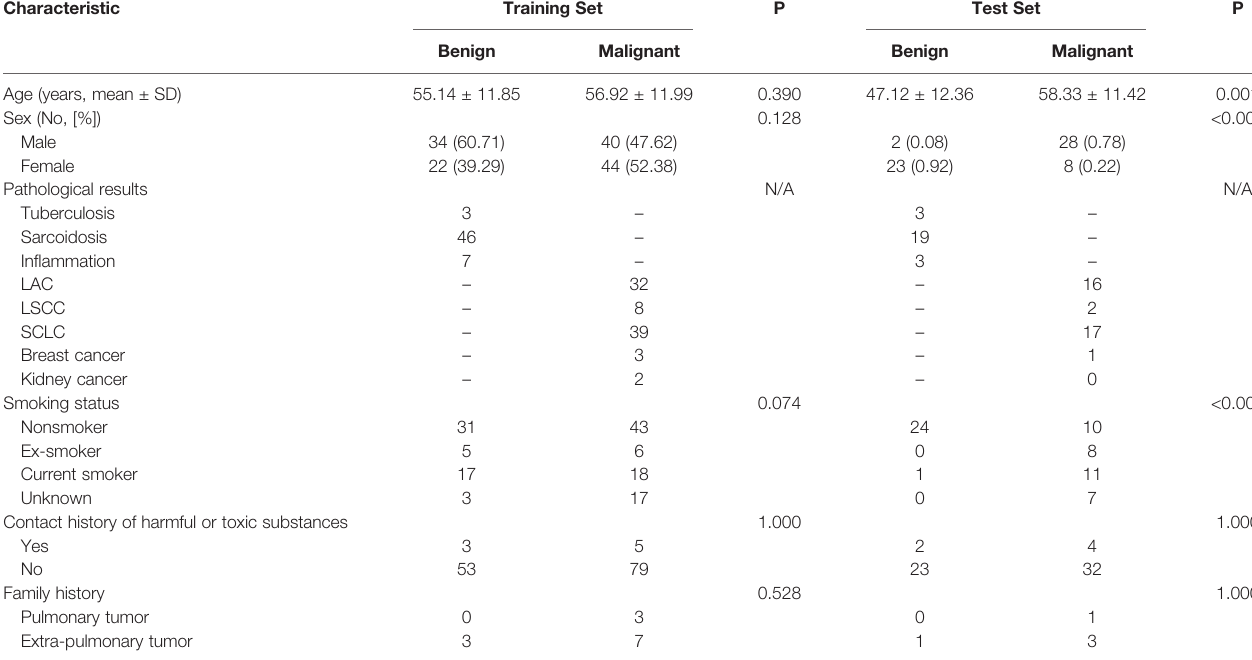
TABLE 2 | Demographic data of benign and malignant group in training set and test set. Characteristic Training Set P Test Set Benign